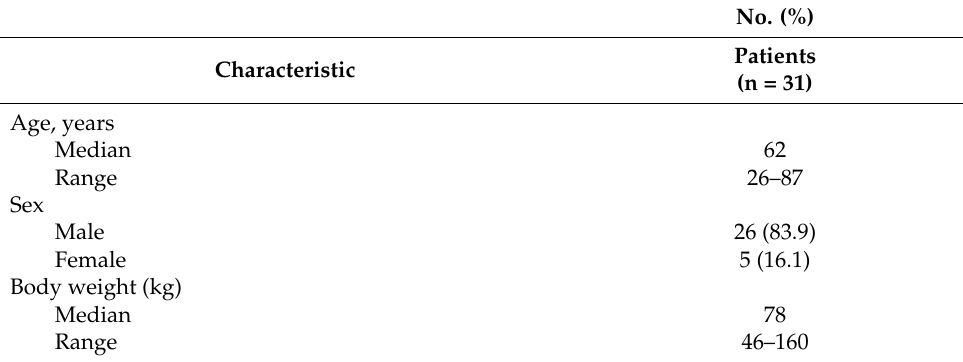
Table 1. Patients’ baseline demographics and clinical